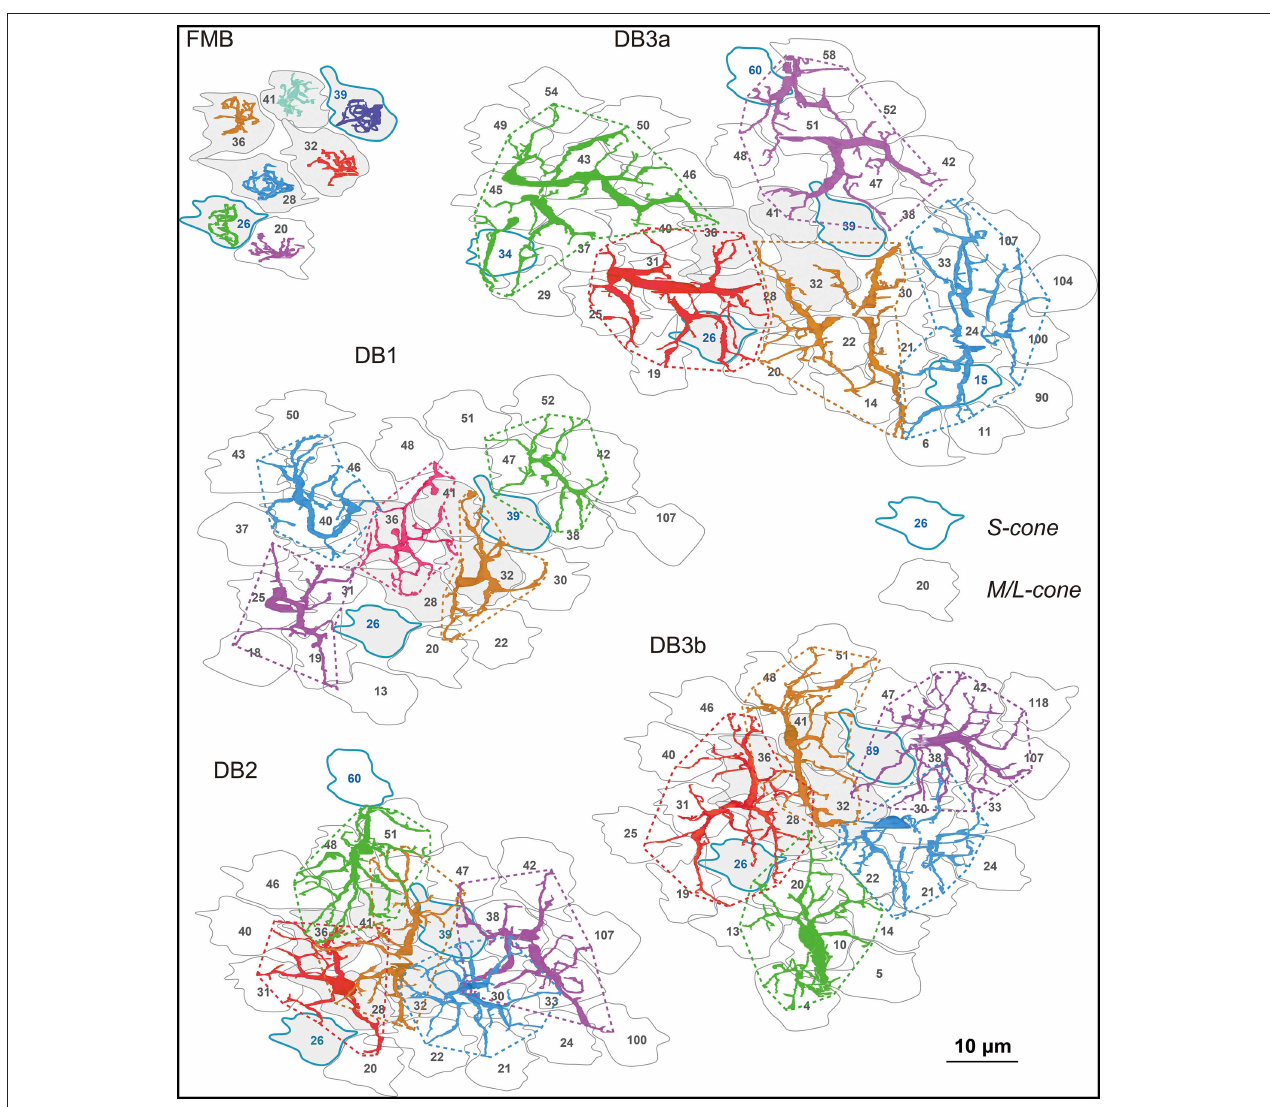
FIGURE 2 | Dendrites of each OFF bipolar cell type covering arrays of cone photoreceptor pedicles. The dendrites of seven (FMB) or five (DB) cells in each subgroup are shown in different colors for clarity. Cone pedicles are labeled by serial numbers and accordingly in the following figures. M/L-cones are labeled with black letters and S cones with blue letters and contours. Each type tiles an area of cone pedicles and most of each cone area is innervated by the dendrites of the five types of OFF bipolar cells. Six central pedicles (26, 28, 32, 36, 39, and 41) are designated in gray for